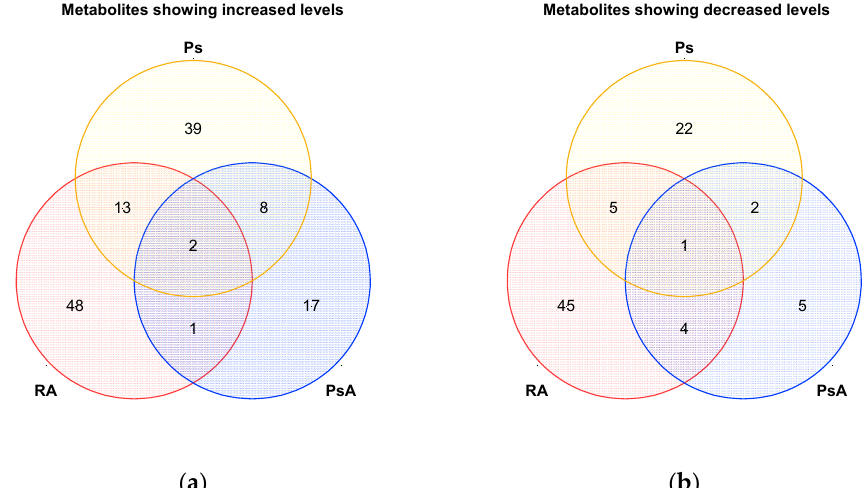
Figure 5. Venn diagrams illustrating potential diagnostic metabolites with ( a ) increased and ( b ) decreased levels for RA, PsA, and Ps. A total of 128 unique metabolites showed increased levels in various matrices, whereas 84 unique metabolites displayed decreased concentrations. A list of the respective metabolites can be found in Supplementary Tables S4 and